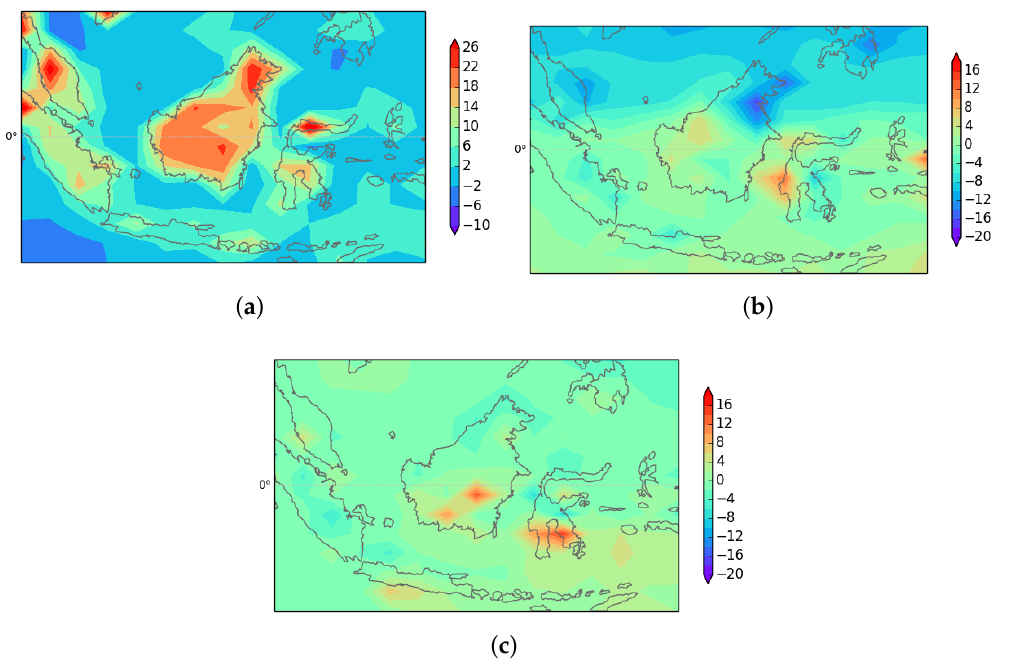
Figure 4. Diagnostics calculated over a region 10 ◦ S to 10 ◦ N and 100 ◦ E to 130 ◦ E at 80 m height above the surface: ( a ) Boundary layer heating, units ◦ K day − 1 ; ( b ) total zonal wind calculated from Equation (20); and ( c ) total meridional wind calculated from Equation